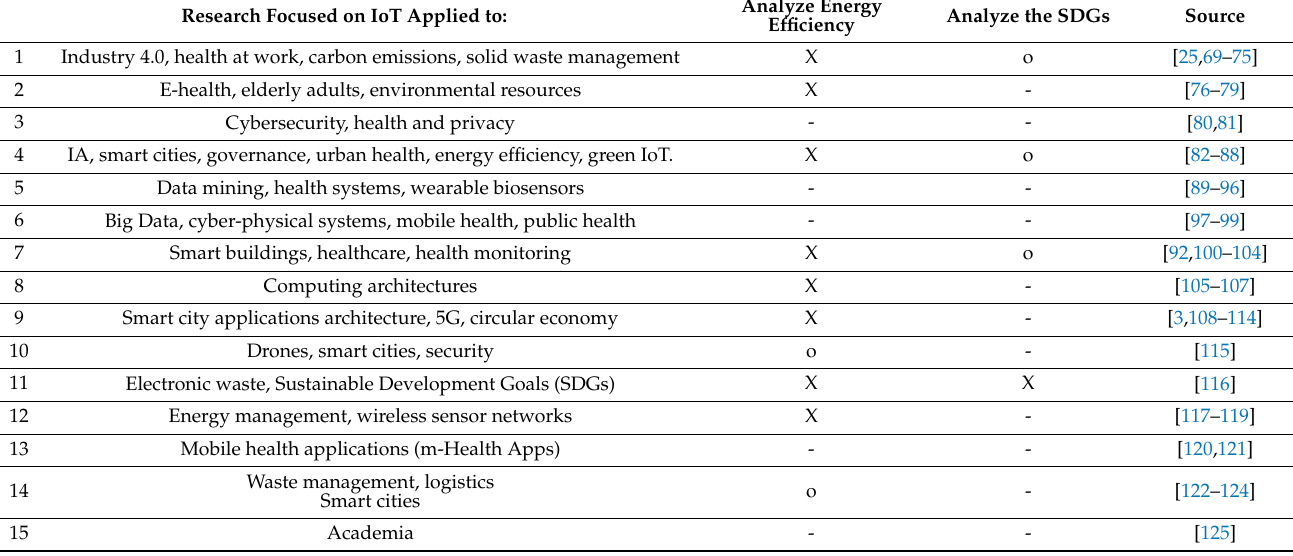
Table 4. Analysis of the sources consulted and their subject